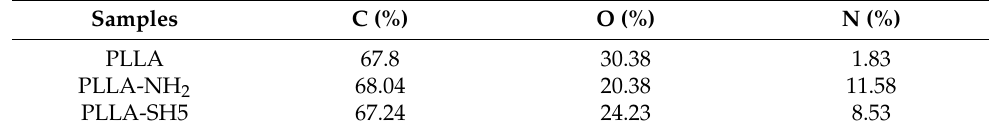
Table 1. XPS results of the atomic composition of PLLA, PLLA-NH2, and PLLA-SH5.